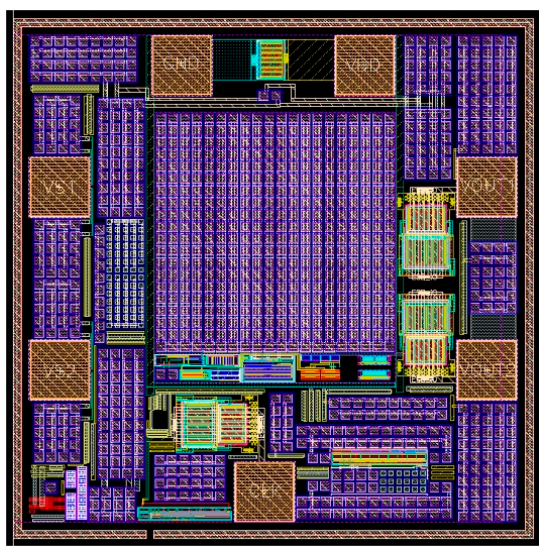
Figure 9. The layout of this design.